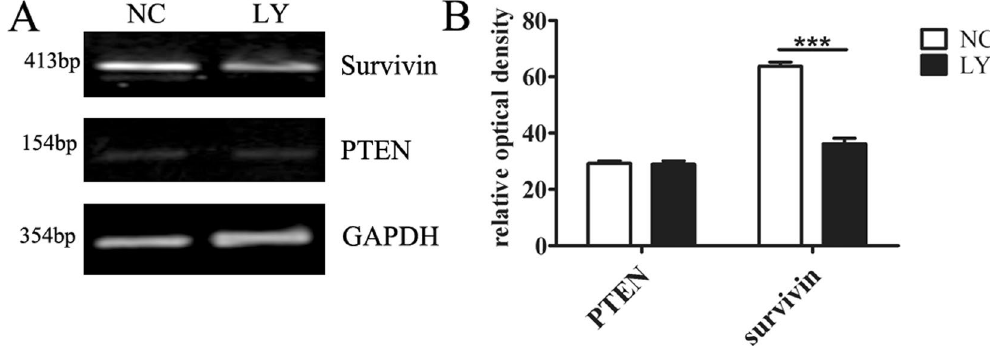
Figure 1. ( A ) The gene expression of survivin was suppressed by the PI3K/Akt pathway inhibitory LY294002. Meanwhile, the PTEN expression was not affected. The direct qPCR was normalized by GAPDH. ( B ) Results of triplicate experiments. The relative optical density of survivin was significantly reduced in comparison to the normal control. “ *** ” stands for P < 0.001.